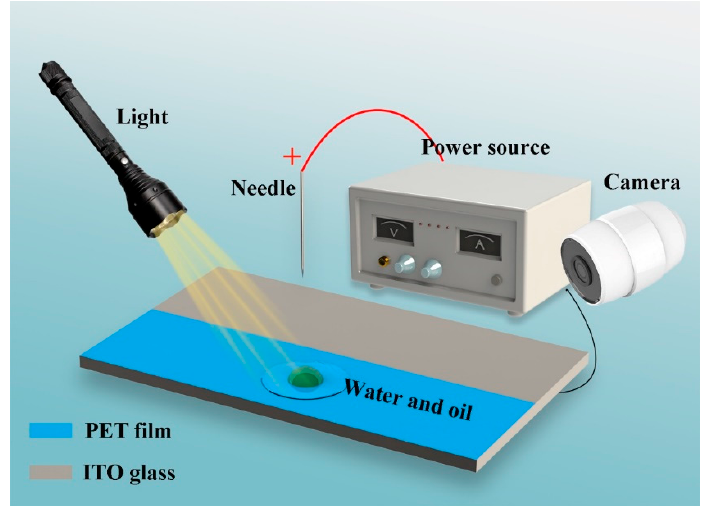
Figure 1. Schematic diagram of the experimental